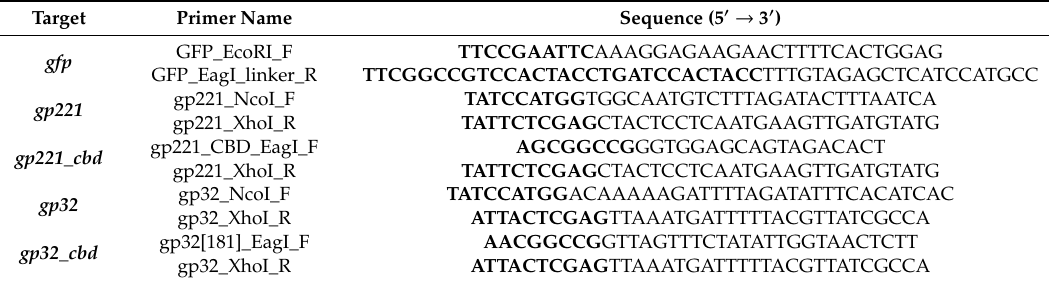
Table 2. Primers used in this study. The extending ends are highlighted in